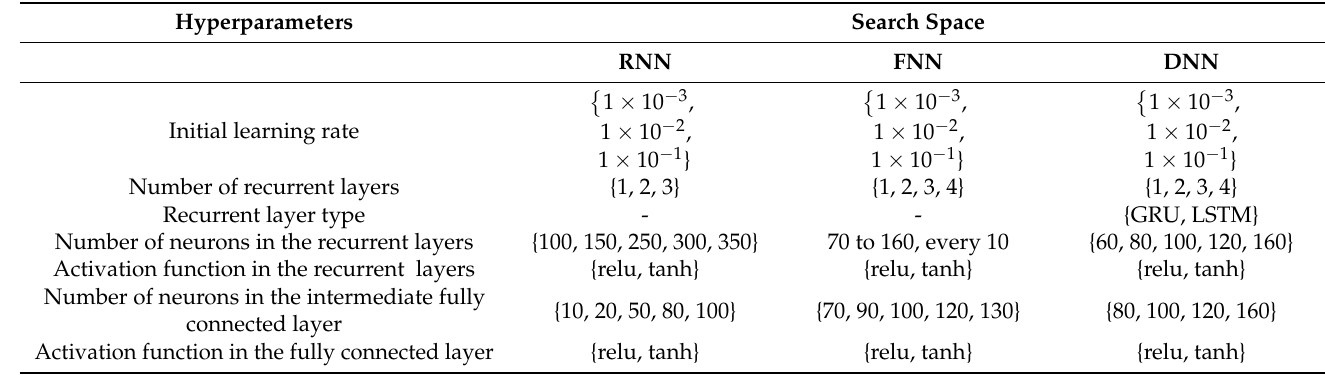
Table 1. Hyperparameter search space for RNN, FNN and DNN.